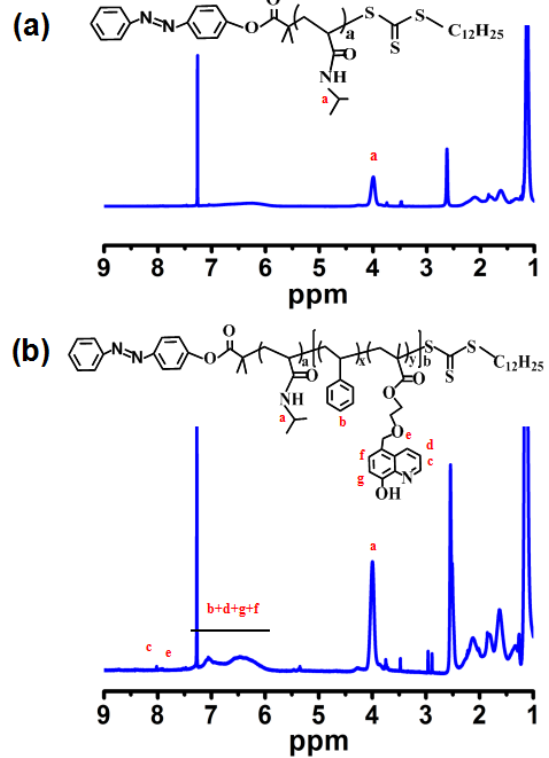
Figure 4. 1 H NMR spectra of PNIPAM ( a ) and PNIPAM- b -P(St- co -MQ) ( b ). Table 1. Characterization data of polymer synthesized by RAFT polymerization.